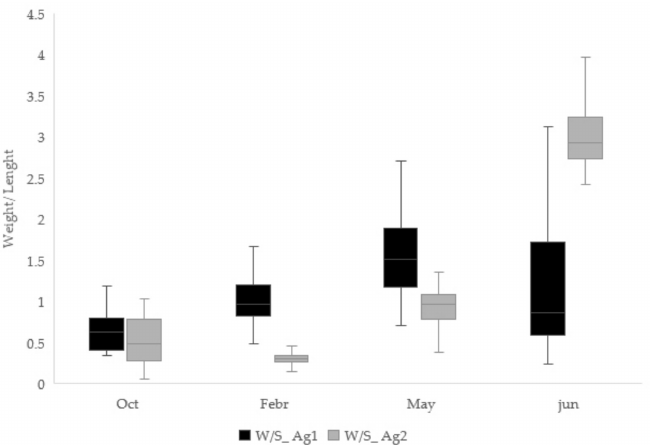
Figure 4. Median weight/length (W/L) ratio of cultivated mussels ( Mytilus galloprovincialis ) in four seasons for the two fish farms (Aq1: Epidauros and Aq2: Evoikos), from October 2020 until June 2021. Data are expressed as the mean ± standard deviation (n = 30 individuals).